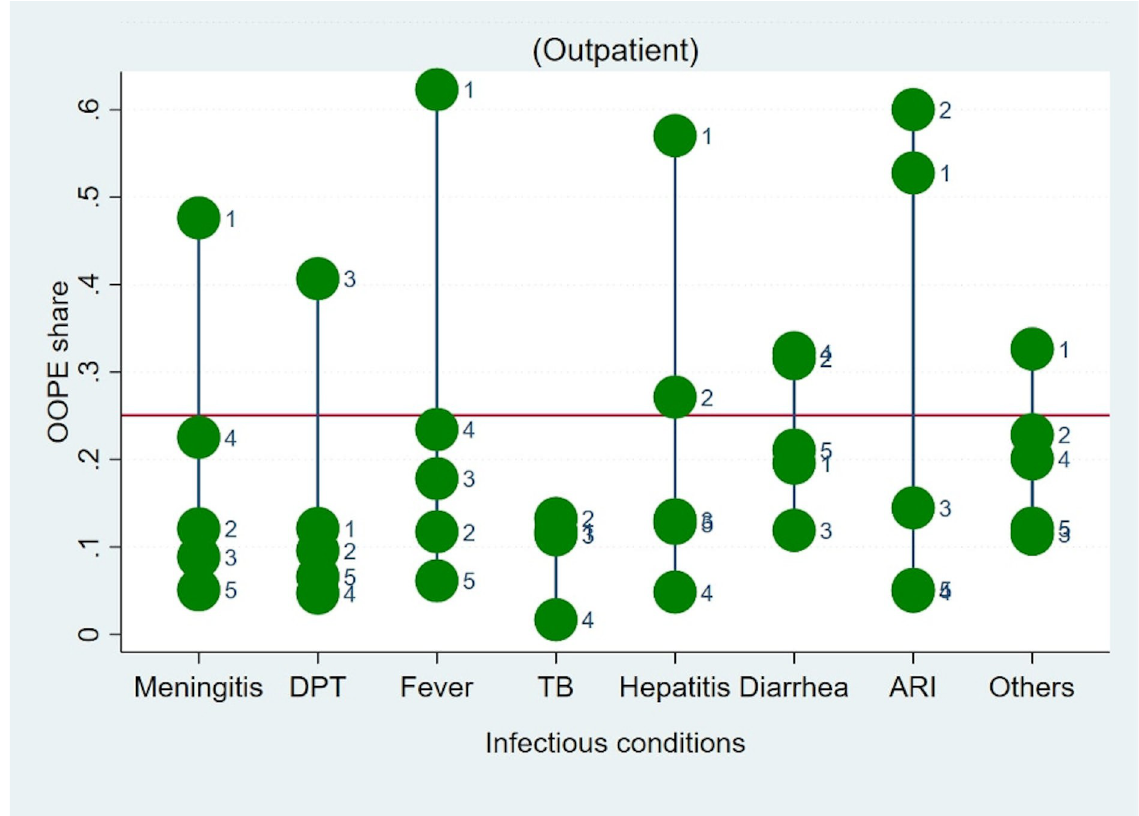
Fig 3. Outpatient OOPE as a share of household total consumption expenditure on different childhood infections by quintile. Notes: Horizontal red line represents mean OOPE as a share of household total consumption expenditure; Q1–1st quintile, Q2–2nd quintile, Q3–3rd quintile, Q4–4th quintile, Q5–5th